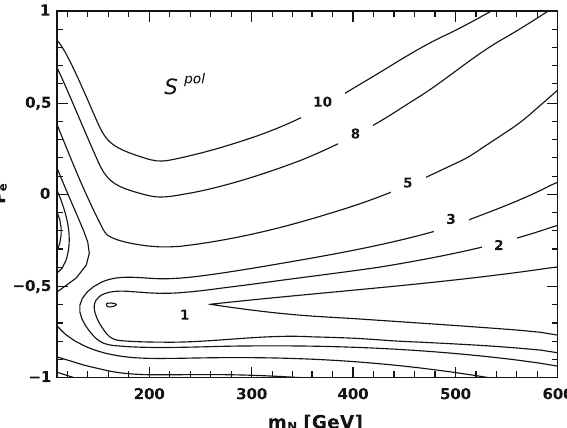
Fig. 10 Contour plot for different values of the function S pol , for L = 100 fb −